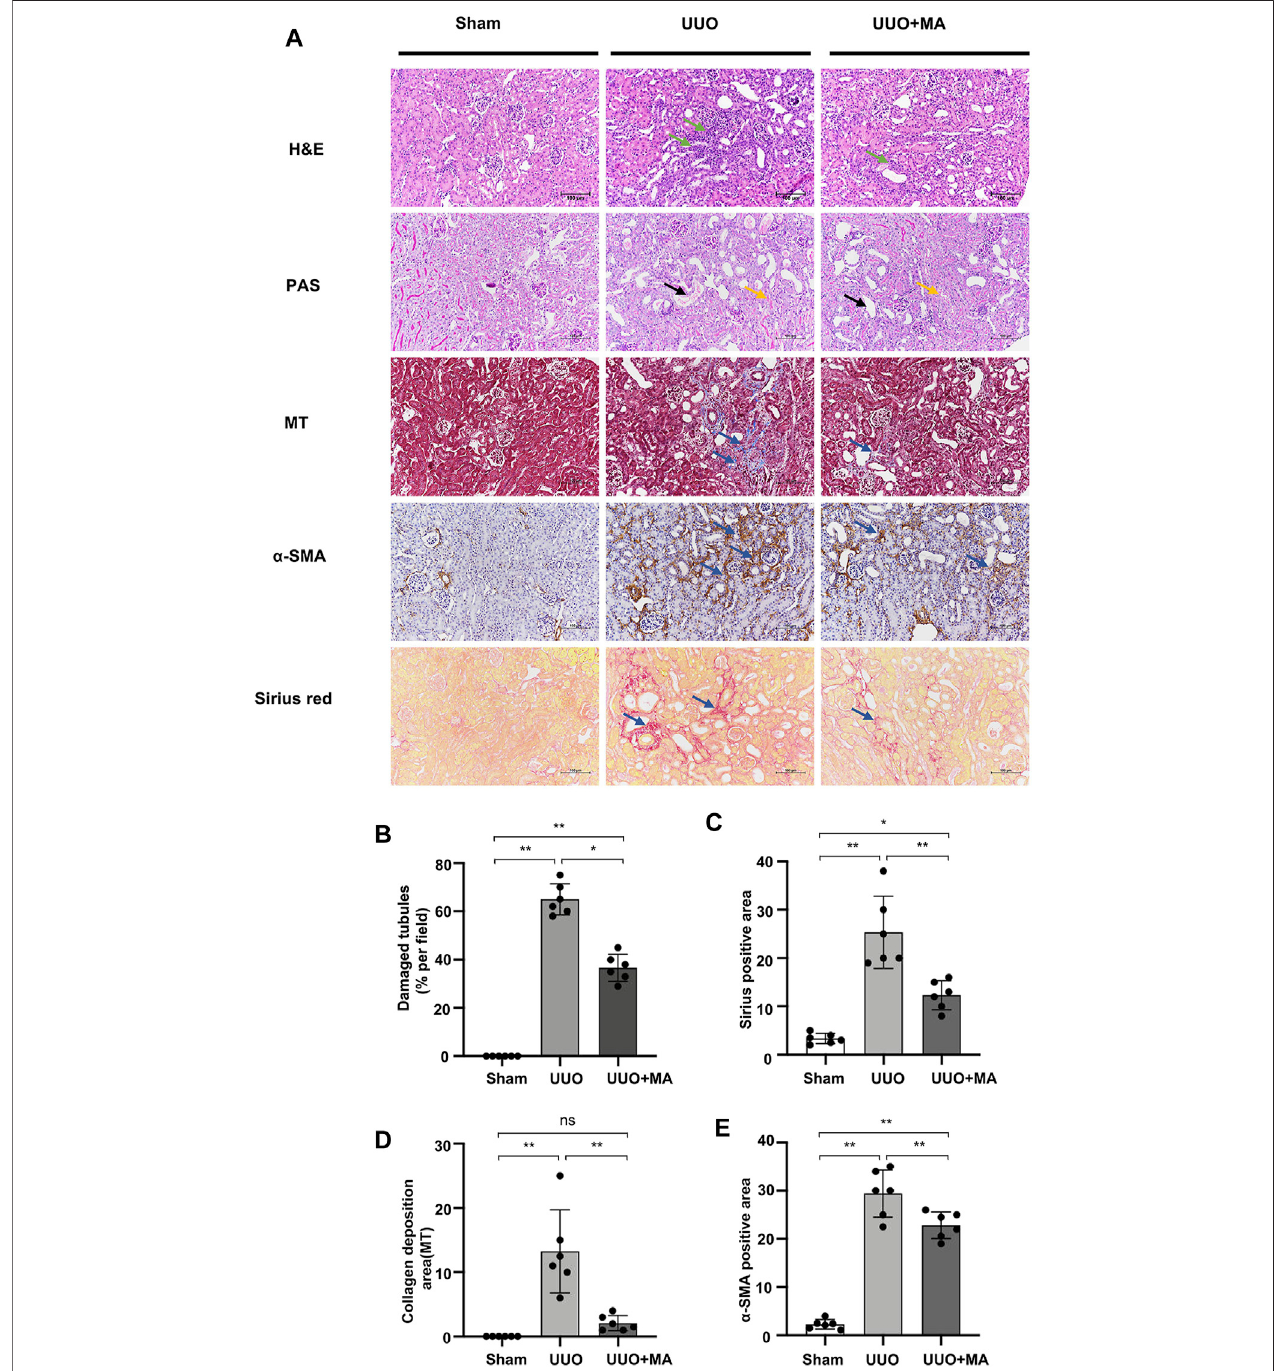
FIGURE1| MAameliorateshistopathologicaldamagesandrenal fi brosisinUUOmodel. (A) HistologicalchangeswereassessedbyH&EandPASstaining.Typical interstitial tubular positive changes were indicated as follows; in fl ammatory cell in fi ltration (green arrow) in H&E stain; tubular brush border fracture (yellow arrow), and tubular atrophy and dilatation (black arrow) in PAS stain. Interstitial fi brosis (blue arrow) was assessed by MT, immunohistochemistry of α -SMA and Sirius red staining. Originalmagni fi cation (cid:1)× 20.Bar (cid:1) 100 μ m. (B) Kruskal-Wallistestfortubulardamage,n (cid:1) 6.* p < 0.05,** p < 0.01,ns:nosigni fi cance. (C – E) Statisticalsigni fi cance was presented as the mean ± SD, n (cid:1) 6. * p < 0.05, ** p < 0.01, ns: no signi fi cance. HE, hematoxylin and eosin; PAS, Periodic Acid-Schiff stain; MT, Masson ’ s trichrome stain; MA, maslinic acid; UUO, unilateral ureteral obstruction.